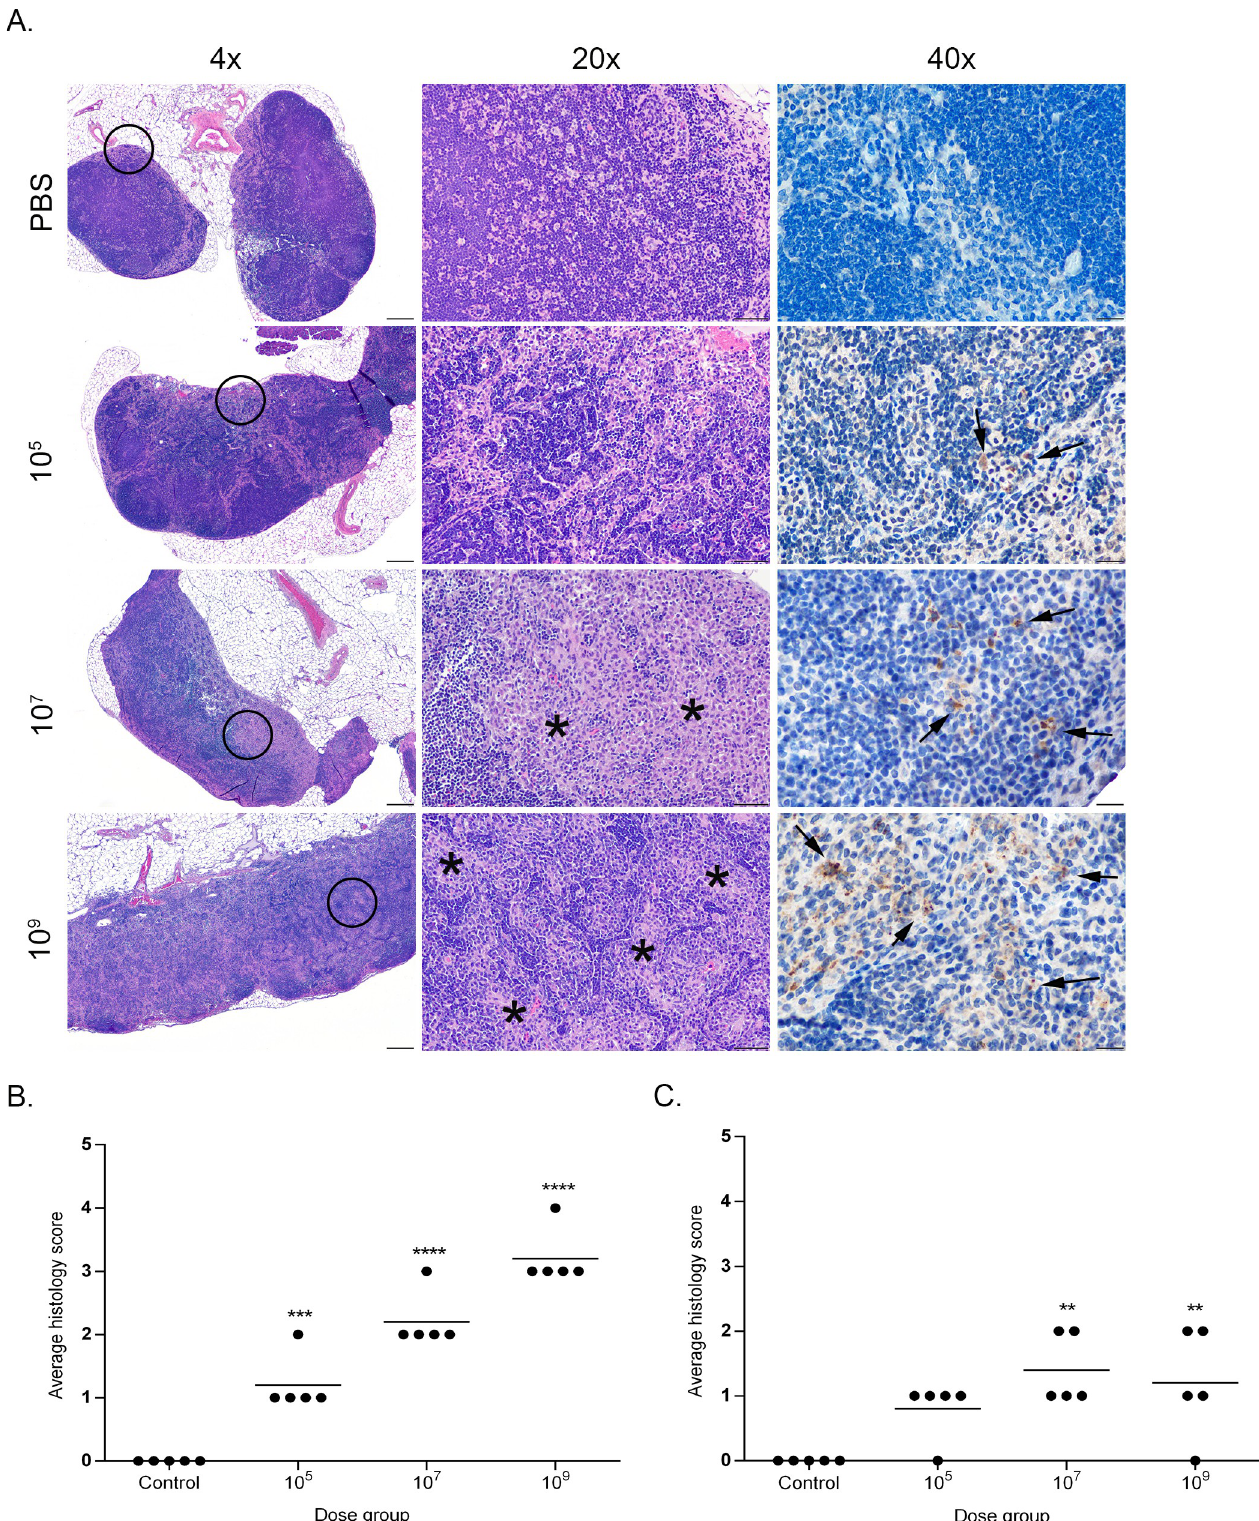
Fig 4. Histopathology of the mesenteric lymph nodes in mice infected with B . canis . (A) Representative images of histopathology and immunohistochemistry of the mesenteric lymph nodes of mice infected intraperitoneally with PBS (top row) or B . canis RM6/66 at a low dose (10 5 , second